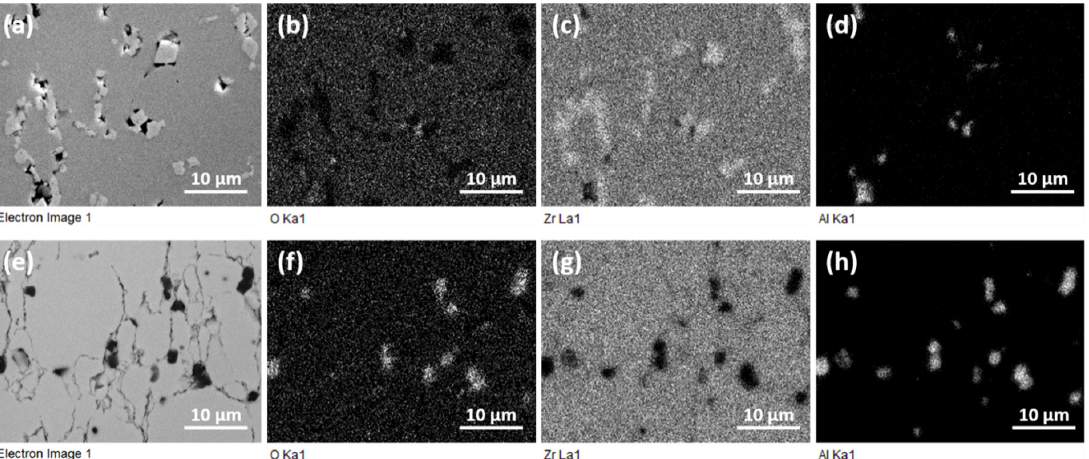
Figure 10. Elemental maps for 5 GAlN composite for edge (upper row) and bulk (bottom row) layers: ( a , e )—SEM images; corresponding ( b , f )—oxygen maps; ( c , g )—zirconium maps; ( d , h )—aluminum maps, taken from SEM image.